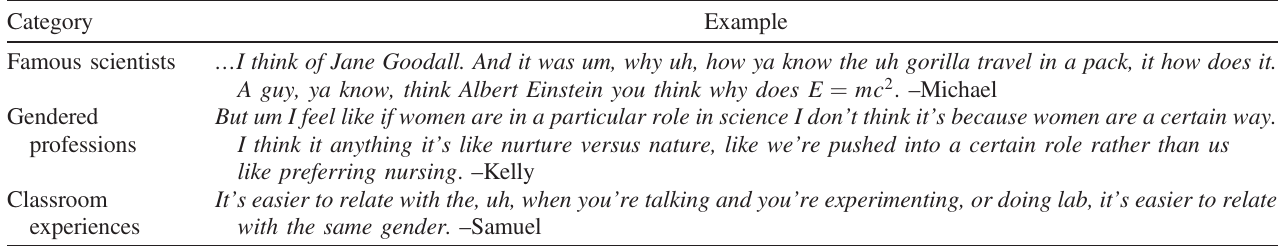
TABLE III. Categories of discussion